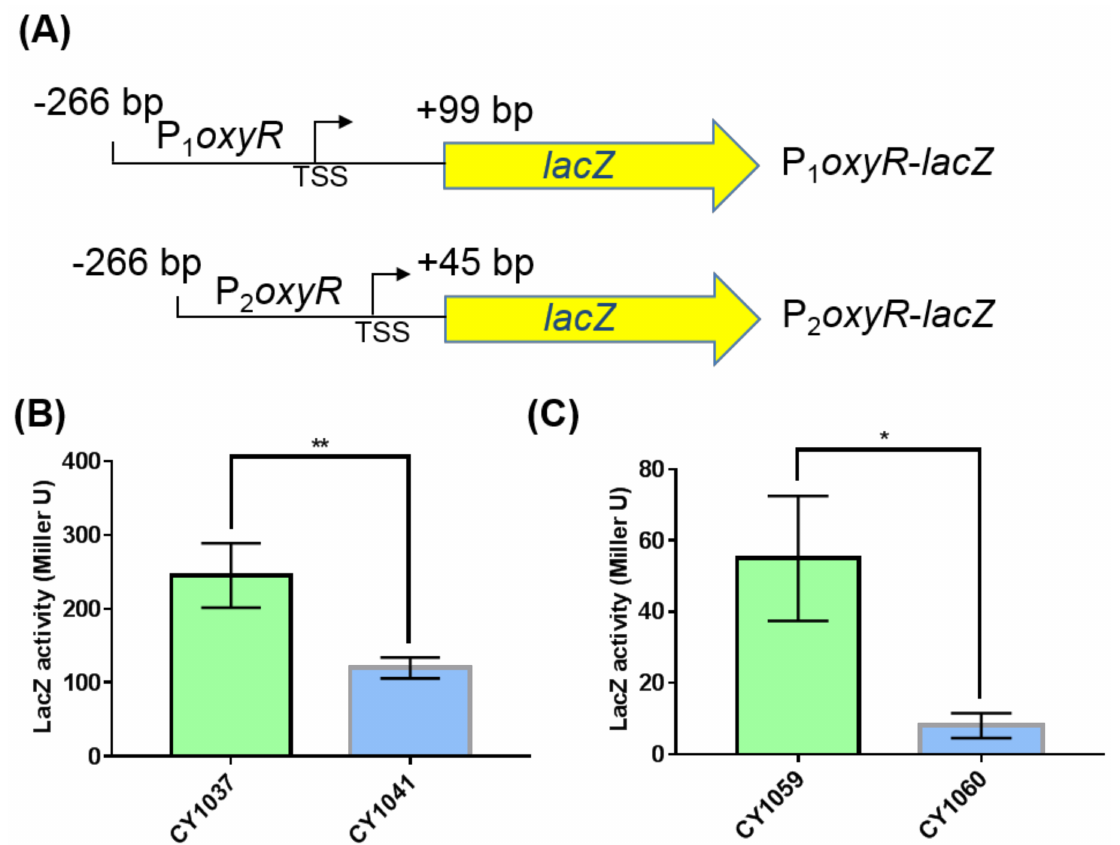
Figure 4. β -galactosidase activities of the oxyR promoter with lacZ translational fusions in the gcvB knockout and wild-type strains. ( A ) Composition diagrams of the promoters of oxyR with lacZ translational fusions. P 1 oxyR covers the DNA region from − 266 bp to +99 bp relative to oxyR translational start point and P 2 oxyR covers the DNA region from − 266 bp to +45 bp relative to oxyR translational start point. Yellow arrow indicates the entire coding region of lacZ . TSS indicates the transcriptional start site of oxyR . ( B ) β -galactosidase activities of P 1 o xyR - lacZ fusion in the gcvB wild-type (CY1037) and knockout strains (CY1041). ( C ) β -galactosidase activities of P 2 oxyR - lacZ fusion in the gcvB wild-type (CY1059) and knockout strains (CY1060). The LacZ activity was shown as the average ± S.D. of three independent experiments. ** p < 0.01, * p < 0.05 using Student’s t